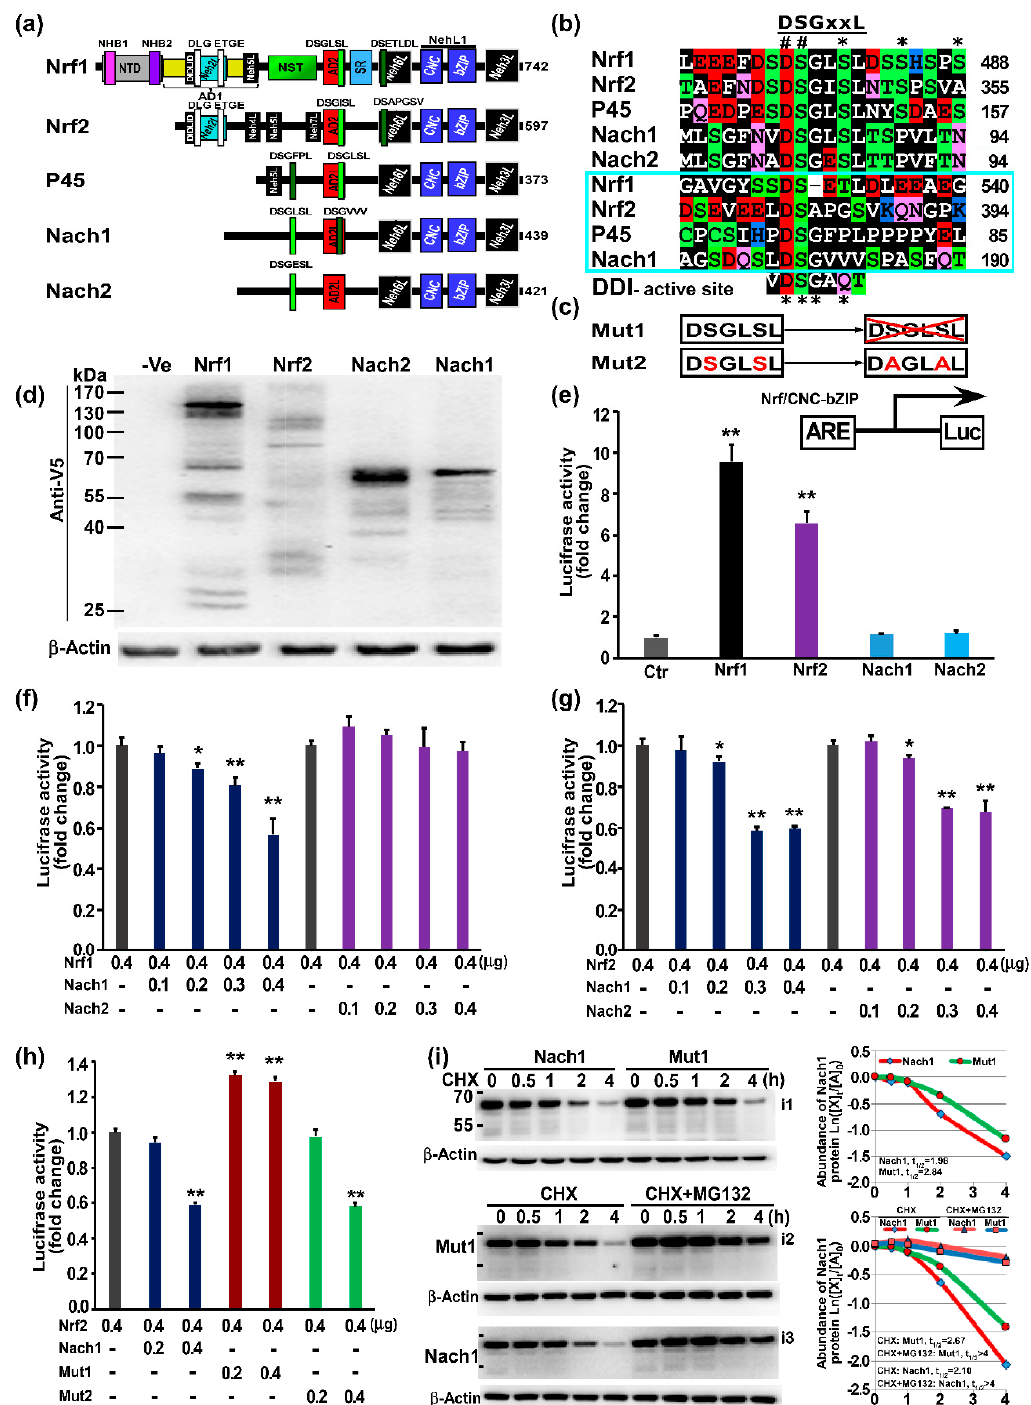
Figure 5. Distinctions in the regulation of ARE-driven reporter gene activity by Nrf1 and Nrf2 from Nach1 and Nach2. ( a ) Schematic representation of structural domains of Nrf1, Nrf2, NF-E2 p45, Nach1 and Nach2, in which the locations of a canonical DSGxSL degron and another non-canonical DSGxxL motif are indicated. ( b ) A multiple alignment of the DSGxSL and DSGxxL (boxed)-adjoining sequence within Nrf1, Nrf2, NF-E2 p45, Nach1 and Nach2. Two similar, but different, degron motifs are highly conserved with the enzymatic active sites (DSGxQx) of the DDI aspartic proteases and hence denoted as a putative suicidon herein. Of note, the critical identical residues DS are indicated by symbols (#), while the consensus GSK-3 β phosphorylation sites are marked by another symbols (*). ( c ) Diagrammatic representation of the DSGLSL motif and its mutants of within Nach1; and ( d ) western blotting of